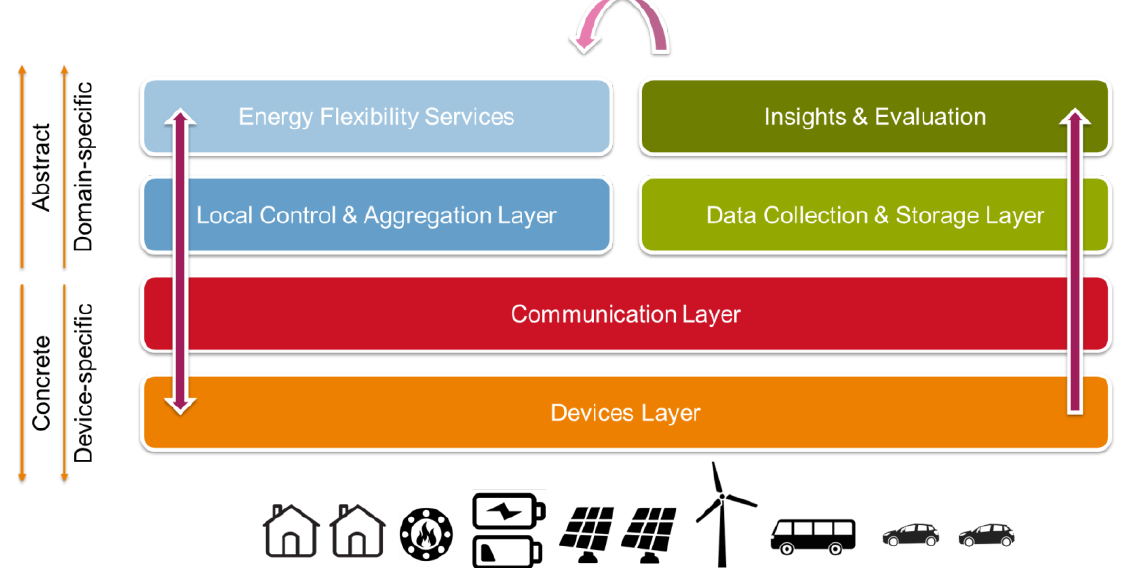
Figure 1. From the concrete, device-specific layer to the abstract, domain-specific one.